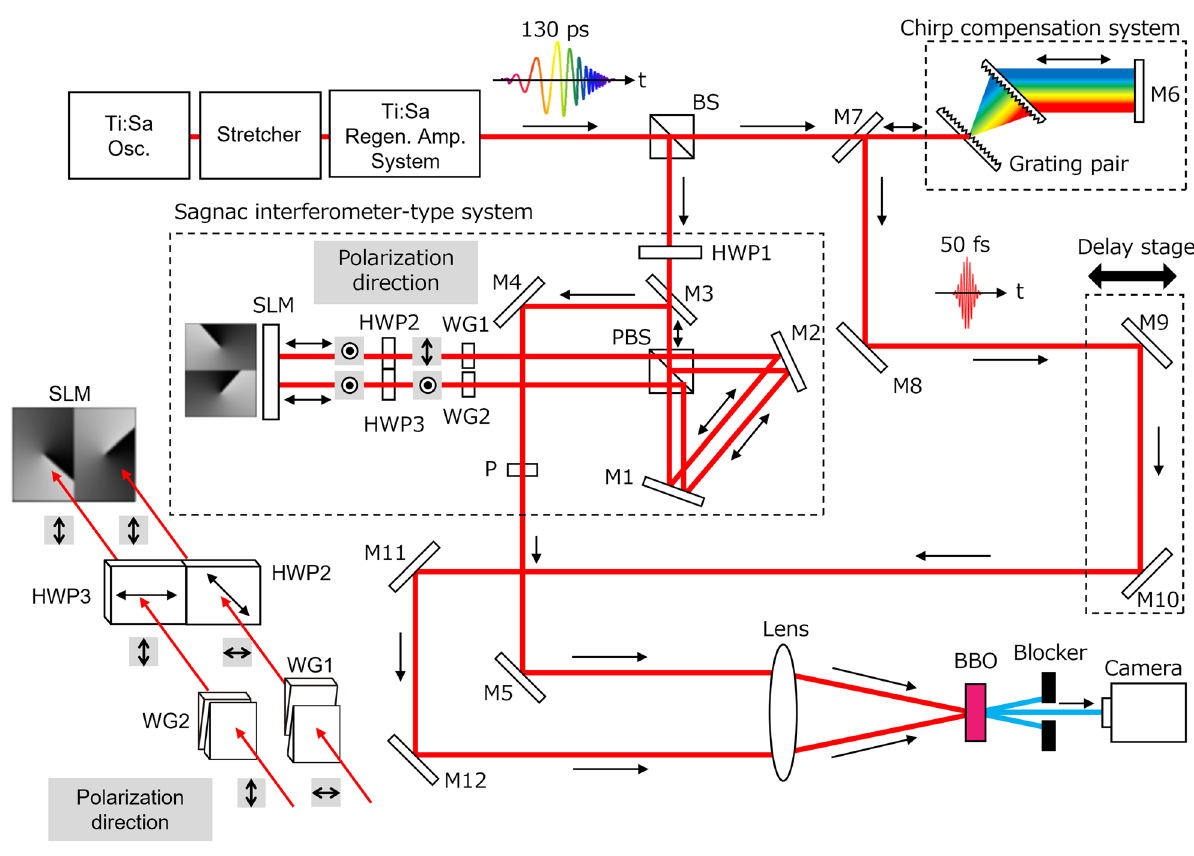
Figure 7. Experimental setup for ultrafast beam pattern modulation. BS, beam splitter; M1-12, mirrors; PBS, polarizing beam splitter; SLM, spatial light modulator; WG1–2, wedged glass; HWP1–3, half-wave plates; P, polarizer; BBO, β -BaB 2 O 4 crystal. M3 is a vertically-shifted mirror for directing the phase-modulated beams by SLM into the time-divided spatial pattern monitoring part. M7 is a vertically-shifted mirror for guiding the reference beam after chirp compensation by a pair of grating into the time-divided spatial pattern monitoring part. A pair of wedged glasses are used in each optical path in the Sagnac interferometer-type system to give a time delay of the chirped pulse pair, avoiding lateral beam shifts. Half-wave plates with fast axes in horizontal and 45 ◦ directions, making vertically-polarized light on SLM, are employed to minimize efficiency difference of the diffraction in two paths. Schematic of wedged glasses, half-wave plates and SLM with polarization relations are depicted in the